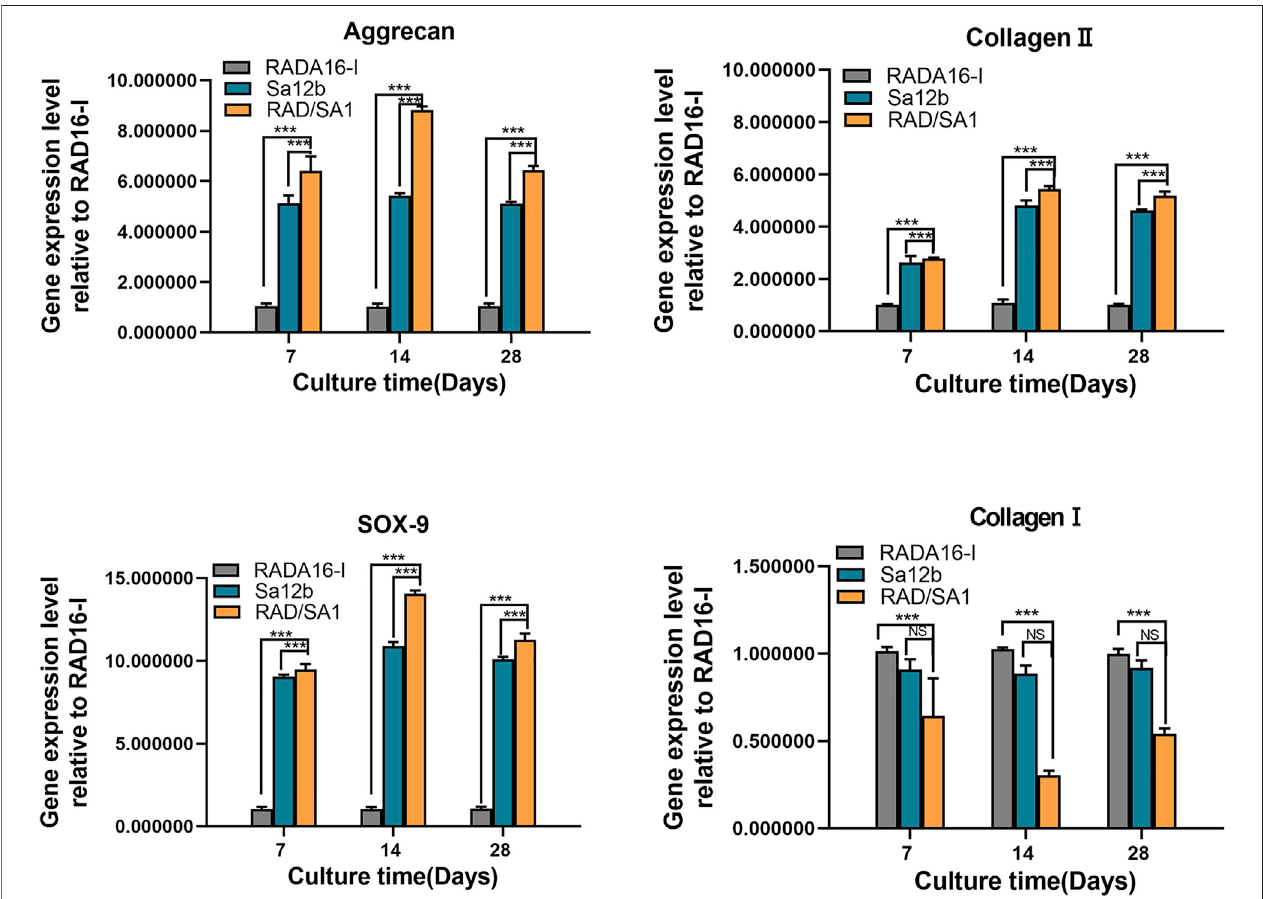
FIGURE 8 | QRT-PCR analysis revealed that the mRNA expression of collagen I, collagen II, aggrecan, and SOX-9 secreted by hNPMSCs were signi fi cantly different among the three groups ( pH = 6.2) after 7, 14 and 28 days, respectively. When the two groups compared, * indicates p < 0.05, ** indicates p < 0.01, and *** indicates p <